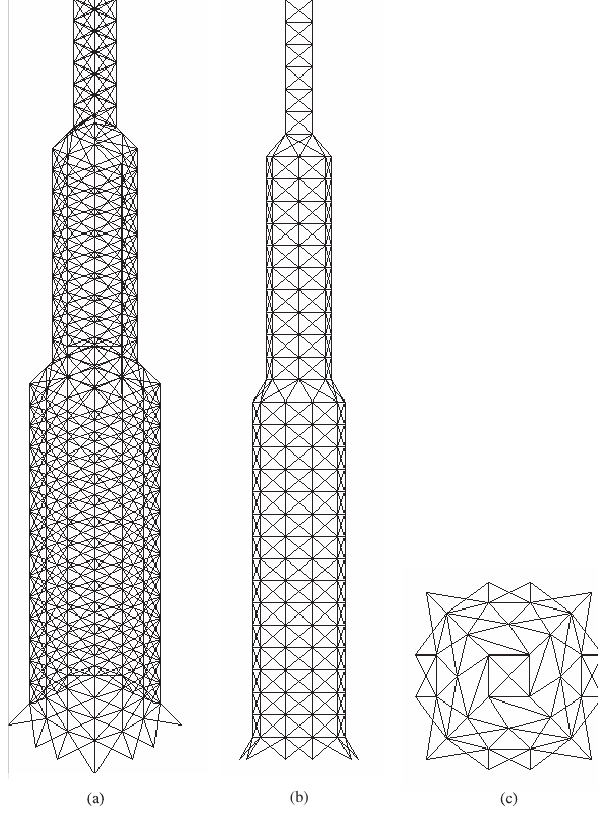
Fig. 6. 3D truss tower: (a) 3D view, (b) side view, (c) top